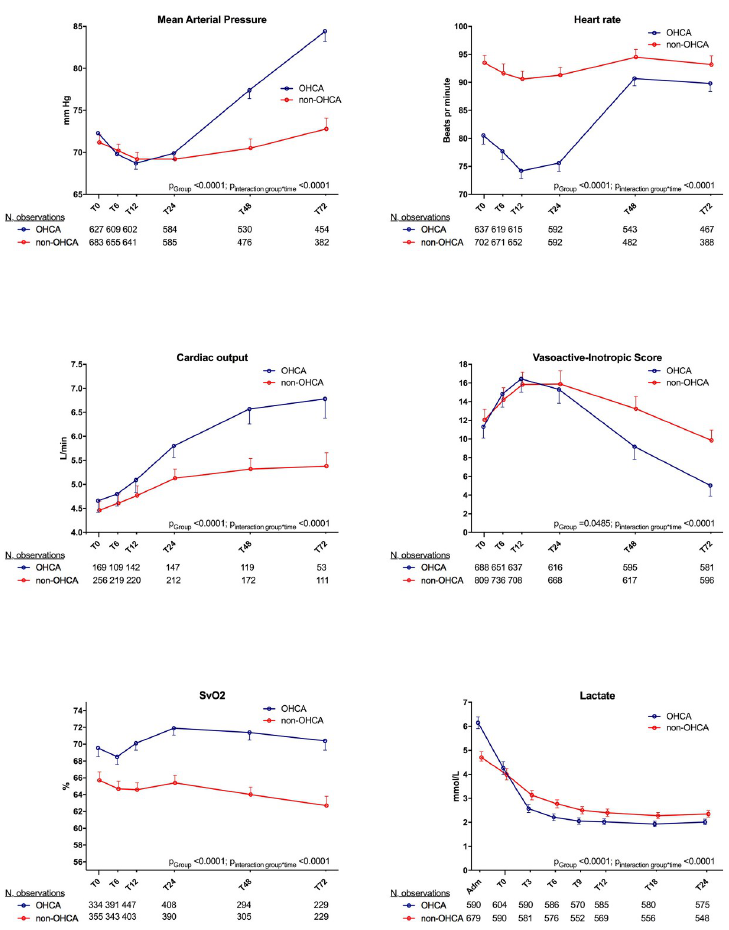
Fig 1. Physiologic parameters and calculated VIS score doses during the first 72 hours after intensive care unit admission among the patients who were admitted to the ICU (n = 1532) are stratified into subgroups presenting with and without out-of-hospital cardiac arrest. OHCA: Out-of-hospital cardiac arrest. Lactate levels are depicted from hospital admission and during the first 24 hours of intensive care unit